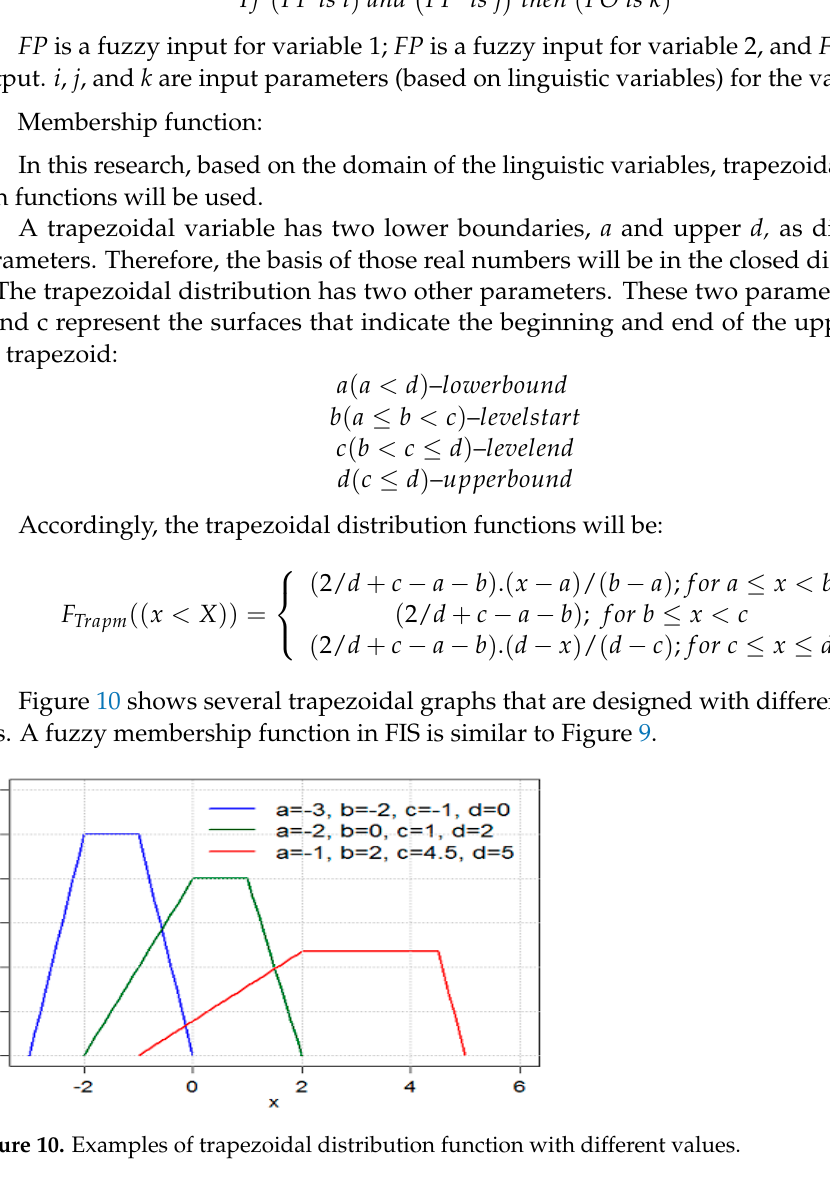
Figure 9. A typical fuzzy diagram for a variable, according to the linguistic variables and domain of them.